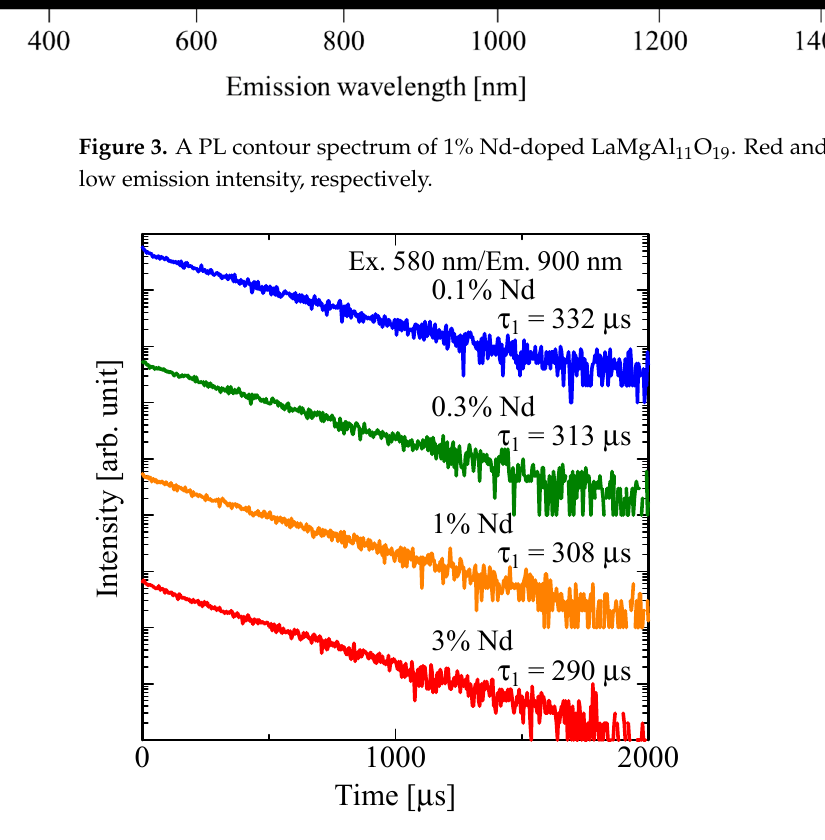
Figure 3. A PL contour spectrum of 1% Nd-doped LaMgAl 11 O 19 . Red and blue indicate high and low emission intensity, respectively.